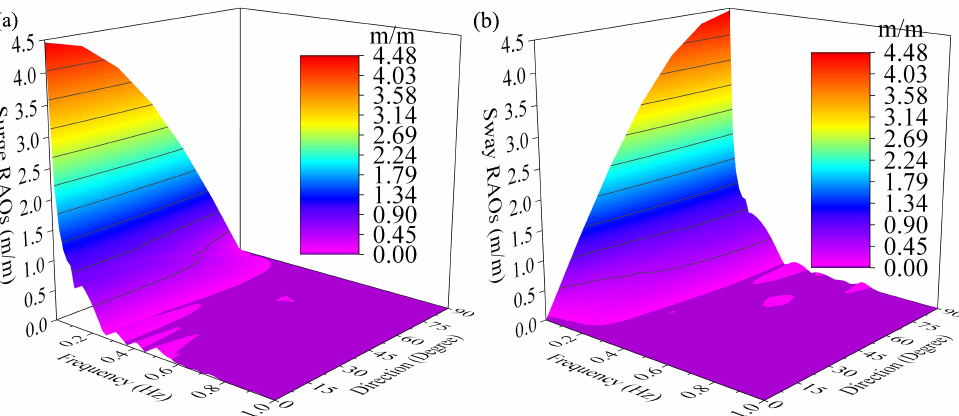
Figure 10. 3D surface plot between the RAOs and the two interacted variables of wave frequencies and wave directions. ( a ) For surge RAOs; ( b ) For sway